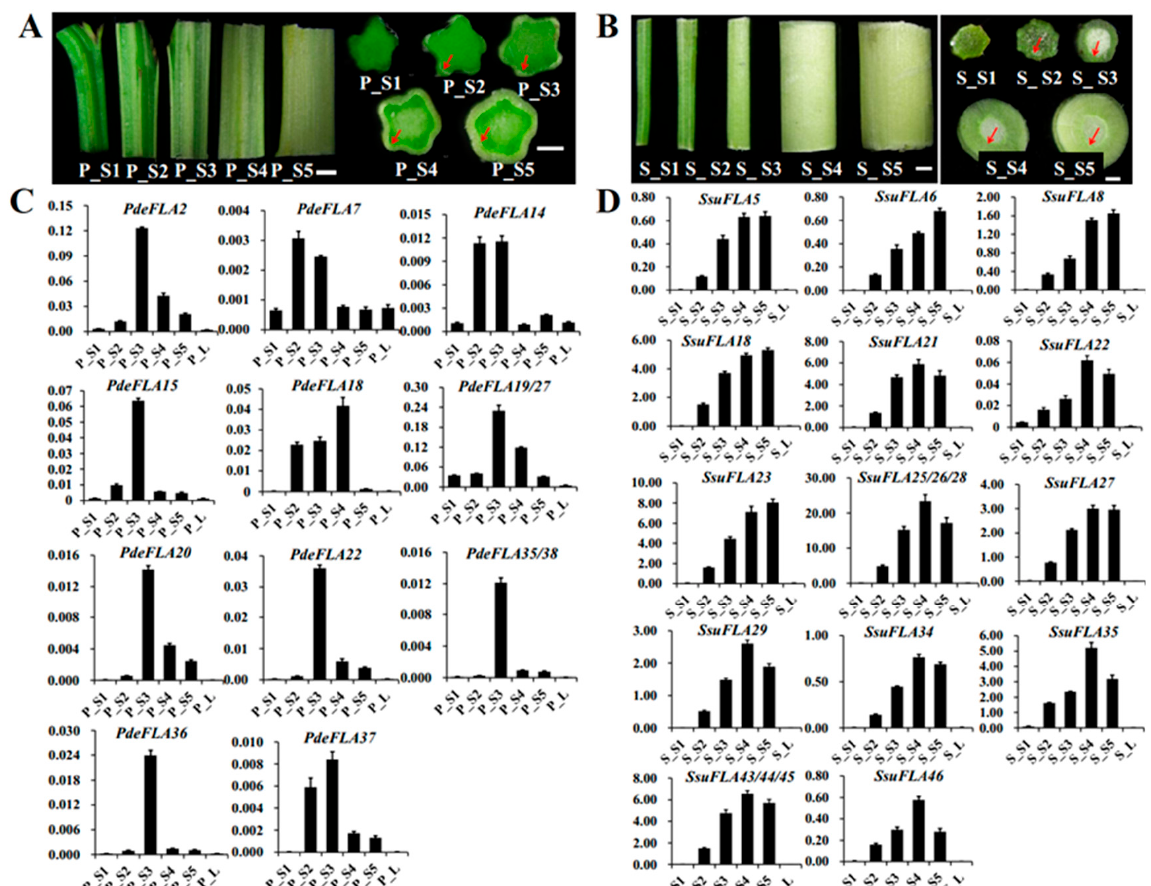
Figure 5. Expression analysis of Group I members of the FLA gene family in P. deltoides and S. suchowensis at different stages of stem lignification development. ( A , B ) Observations of P. deltoides and S. suchowensis at stem lignification development sites. The red arrow points to the xylem. Scale bar = 0.5 mm. ( C , D ) Expression pattern analysis of Group I members in P. deltoides and S. suchowensis . The X -axis represents different tissues and the Y -axis represents relative expression. Values shown are means ± SD of three biological replicates .